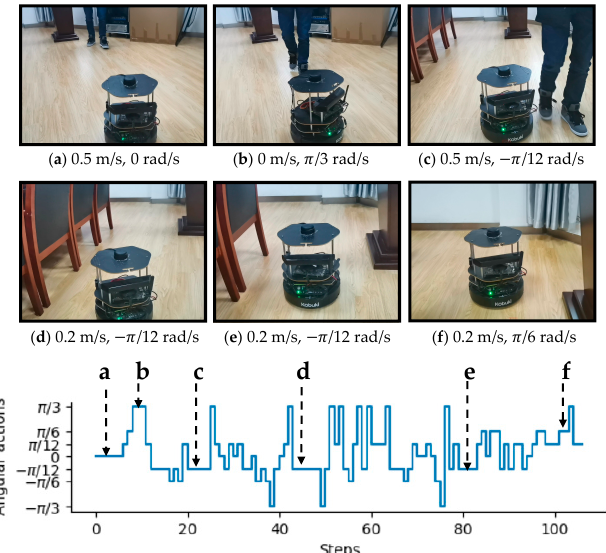
Figure 13. An example of dealing with dynamic obstacle in a real-world meeting room. The Editable version subfigures show the third-person view of six intermediate time steps and the sub-captions indicate the corresponding linear and angular velocity commands. Angular velocity commands in all time steps are provided at the